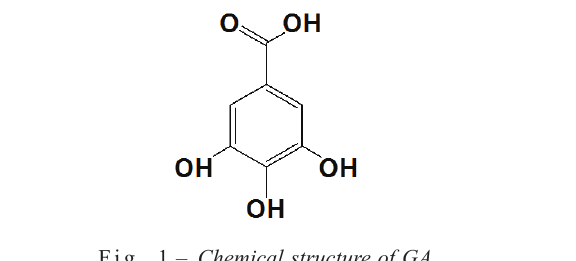
Fig. 1 – Chemical structure of GA Figure 1 Chemical structure of